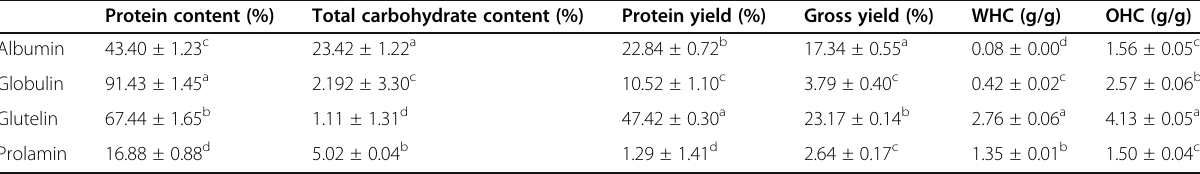
Table 1 Gross, protein yield and protein content of sesame protein fractions isolated from defatted sesame meal Protein content (%) Total carbohydrate content (%) Protein yield (%) Gross yield